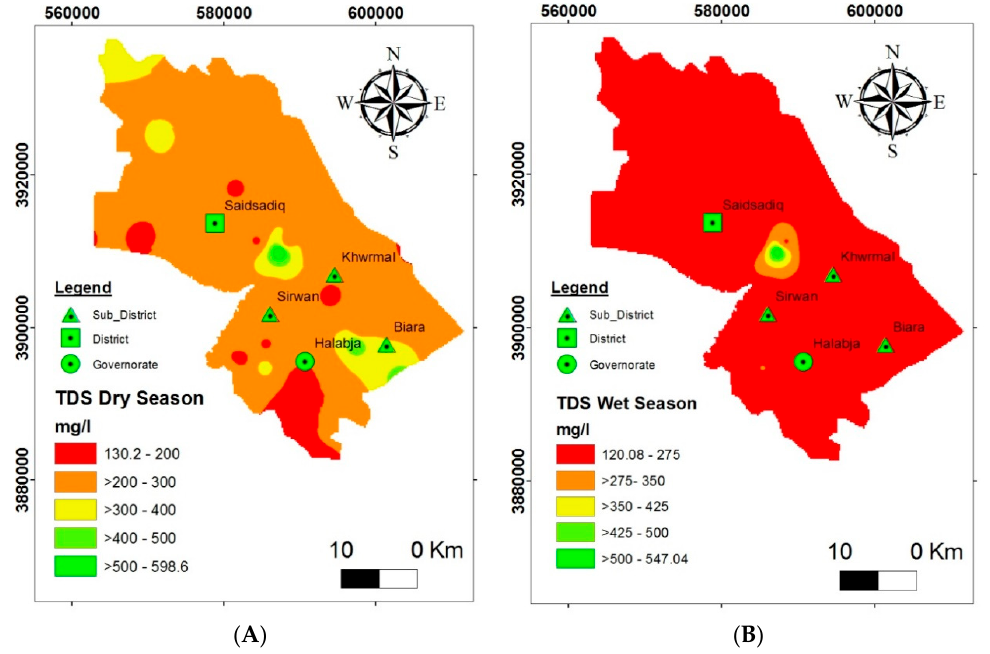
Figure 8. Suitability of groundwater for domestic purposes based on the spatial distribution of TDS: ( A ) dry season and ( B ) wet season.